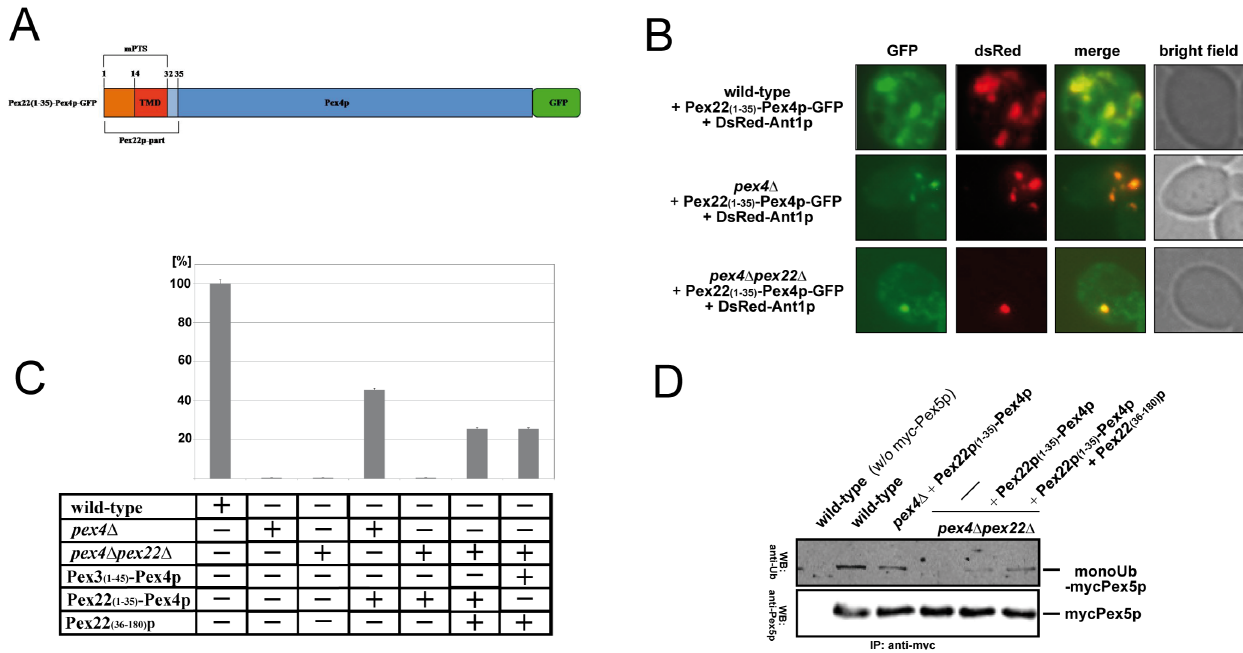
Figure 5. The stimulating effect of Pex22(C)p on Pex5p ubiquitination and peroxisomal function cannot be enforced or replaced by Pex22(N)p. ( a ) Schematic representation of Pex22(N)-Pex4p. The Pex22(aa1–35)-fragment contains the transmembrane domain (TMD) in red and the intraperoxisomal part in orange fused to full-length Pex4p ( blue ) as well as green fluorescent protein ( green ). ( b ) Pex22(N)-Pex4p-GFP is targeted to peroxisomes. The Pex22(N)-Pex4p-GFP construct was introduced in wild-type, pex4 D and pex4 D pex22 D cells as indicated and co-localization of the chimeric protein with the peroxisomal membrane marker DsRed-Ant1p was analyzed under by fluorescence microscopy. ( c ) The functionality of indicated constructs was tested by analysis of their capability to complement the growth defect of depicted strains. To this end, the Pex3(N)-Pex4p and/or Pex22(C)p or Pex22p encoding information was expressed in the pex4 D pex22 D , pex4 D or pex22 D deletion strains, as indicated. The optical density (OD600) of cells grown in oleate medium was monitored (n=3 experiments) and the results are presented in % in comparison to the wild- type ( + / 2 standard error of the mean). While Pex22(N)-Pex4p complements the growth defect of the pex4 D strain, it is only capable to regain functionality in the pex4 D pex22 D background, when Pex22(C)p is present. ( d ) The Pex22(N)-Pex4p fusion protein is capable to monoubiquitinate Pex5p in vivo . In the absence of full-length Pex22p, the level of monoubiquitinated Pex5p is significantly reduced, which is compensated in the presence of